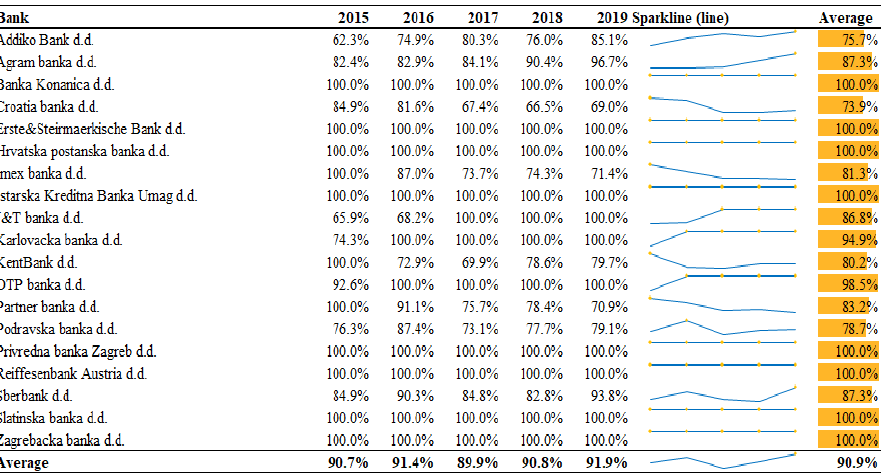
Figure 3. Croatian commercial banking efficiency results.